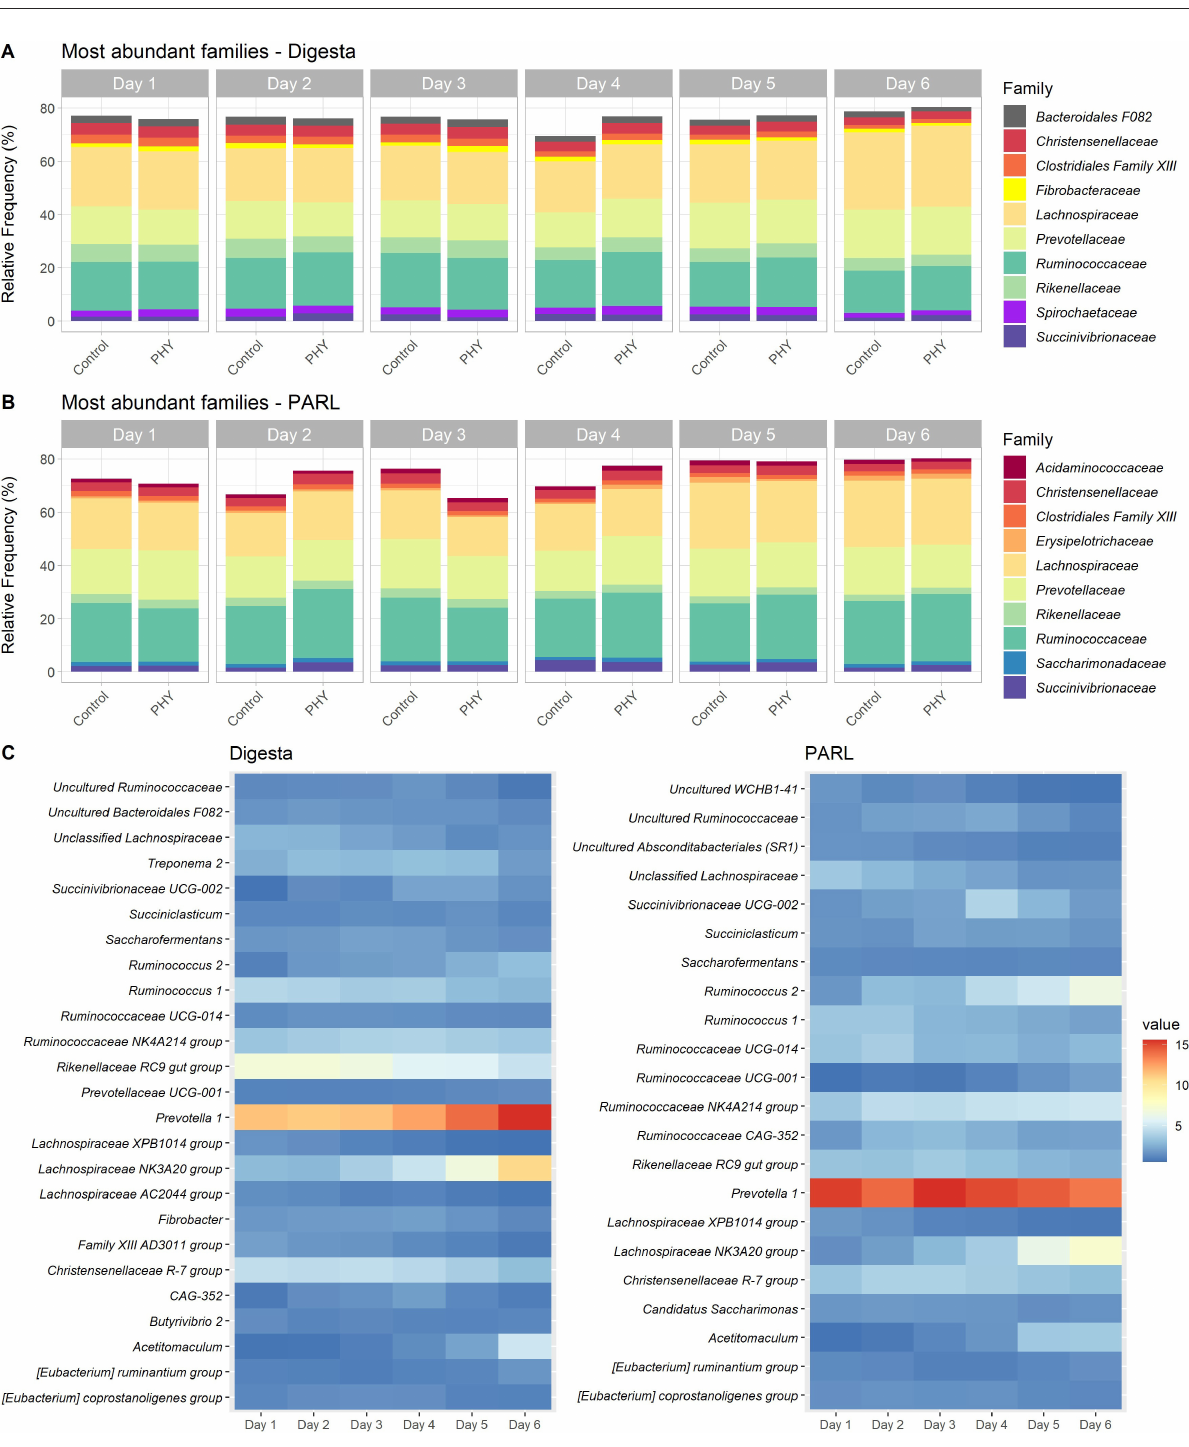
FIGURE3 Microbiota composition of the rumen samples. Bar plots showing the mean relative frequency of the 10 most abundant families (across all samples) in (A) solid digesta and (B) particle associated rumen liquid (PARL) over the experimental days and between the two experimental groups (PHY and control). The heatmaps (C) show the mean relative frequency of the 25 most abundant genera across all samples for solid digesta (Digesta) and particle associated rumen liquid (PARL) over the experimental